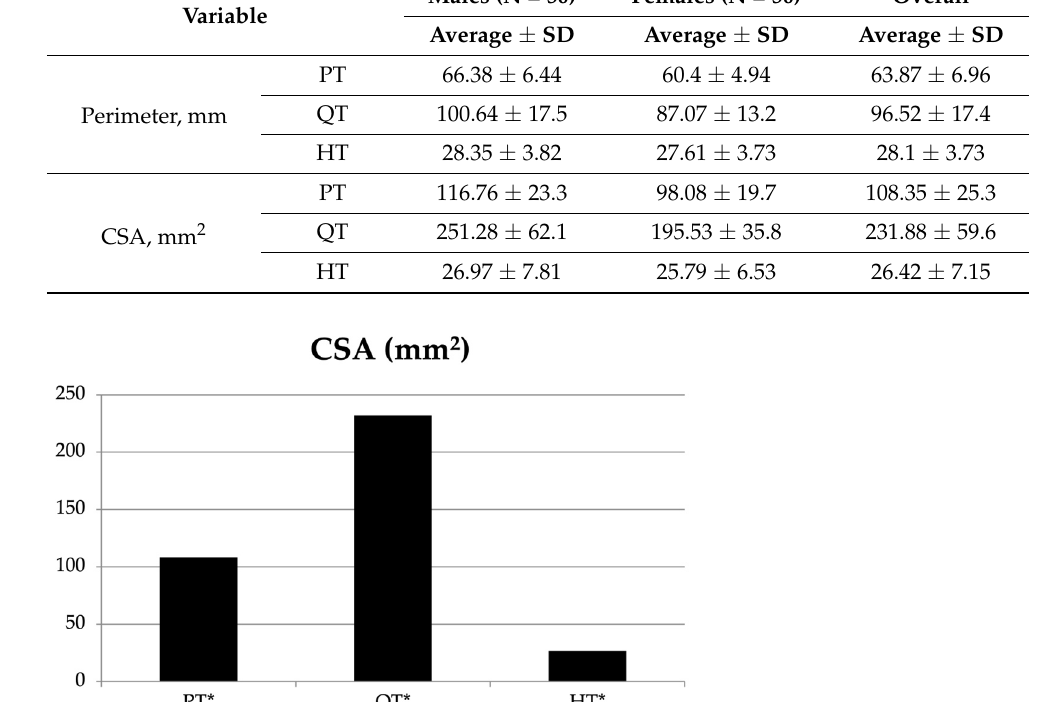
Table 3. Mean length of the patellar and the quadriceps tendon according to sex. SD, standard de ‐ viation. Table 4. Measurement of the Perimeter and the Cross-Sectional Area (CSA) for the Patellar Tendon (PT), the Quadriceps Tendon (QT), and the Hamstring Tendons (HT), overall, and according to sex. Variable